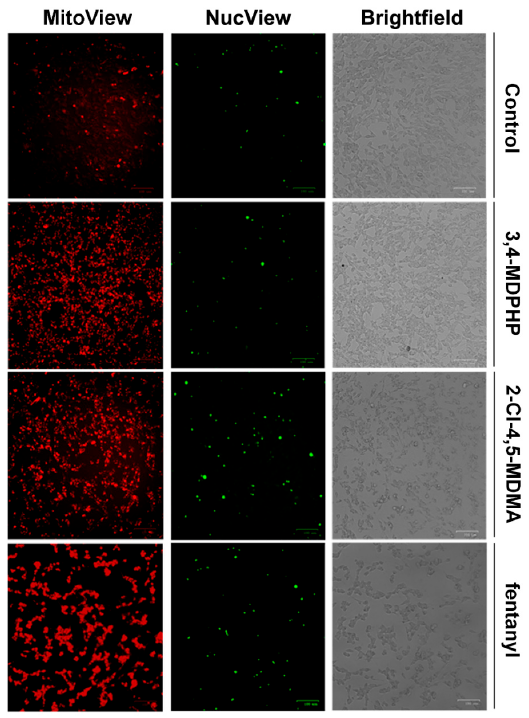
Figure 8. NucView 488 (caspase-3 substrate, green) and MitoView 633 (polarized mitochondria